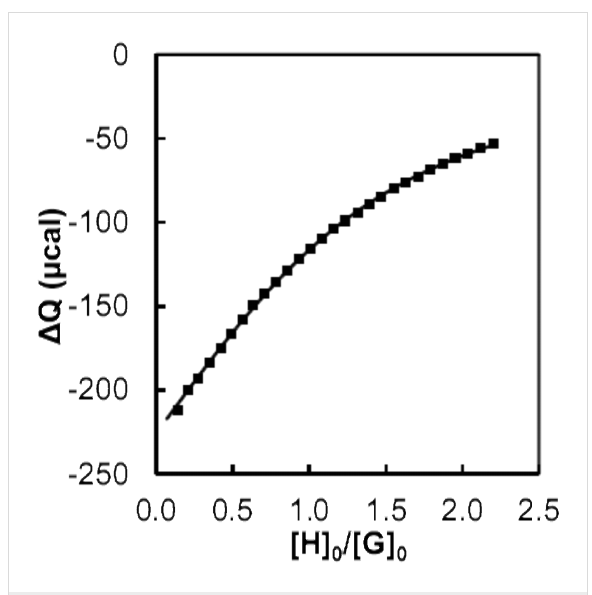
Figure 2: ITC titration of Fc-PEG (1.03 mM; cell) with native CD (10 mM; burette). H = host and G = guest. Experimental binding curve (markers) and best fit to a 1:1 model